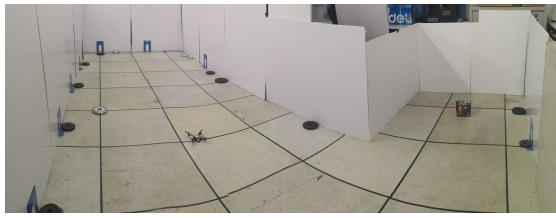
Figure 19. L-shaped test site.